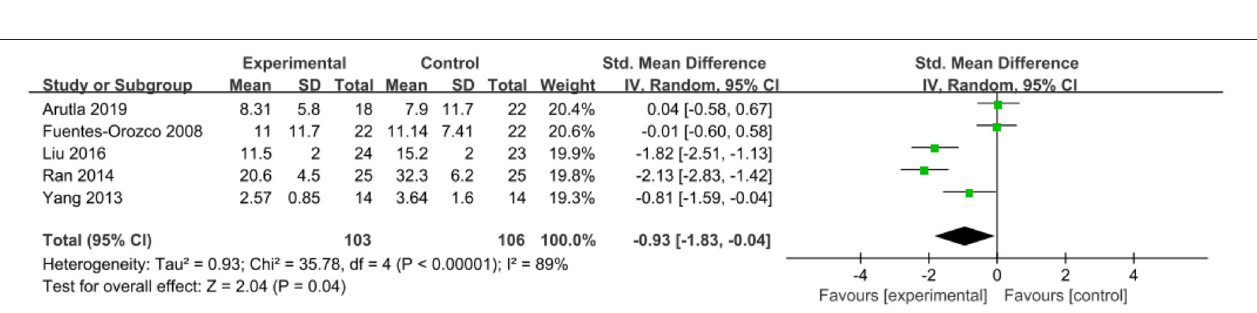
FIGURE 5 | Forest plots of APACHE II score associated with experimental group (parenteral or enteral nutrition group supplemented with Gln) vs. control group (conventional nutrition group). I 2 tests and P are the criteria for the heterogeneity test, (cid:7) , pooled mean difference; — (cid:4) —, mean difference, and the edges of (cid:7) , 95% CI.